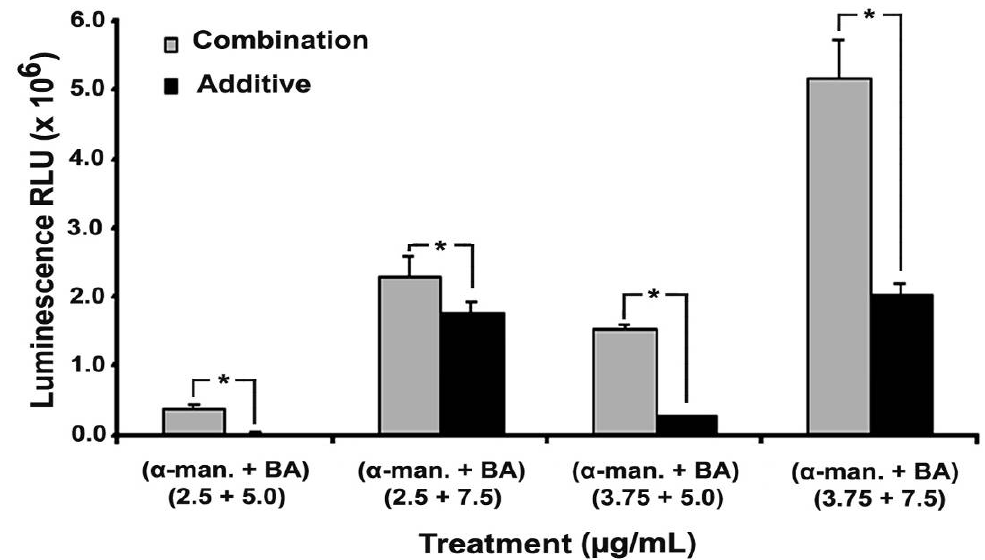
Figure 5. Effect of α -mangostin/BA combination on caspases 3/7 of HCT 116 cells. α -Mangostin, at 2.5 and 5.0 µg/mL, was added to betulinic acid (BA) at 5.0 and 7.5 µg/mL. The results are displayed as average relative light units (RLU). The effect of α -mangostin/BA combination was compared to the additive effect by student’s t -test, and ( * ) indicates P value <